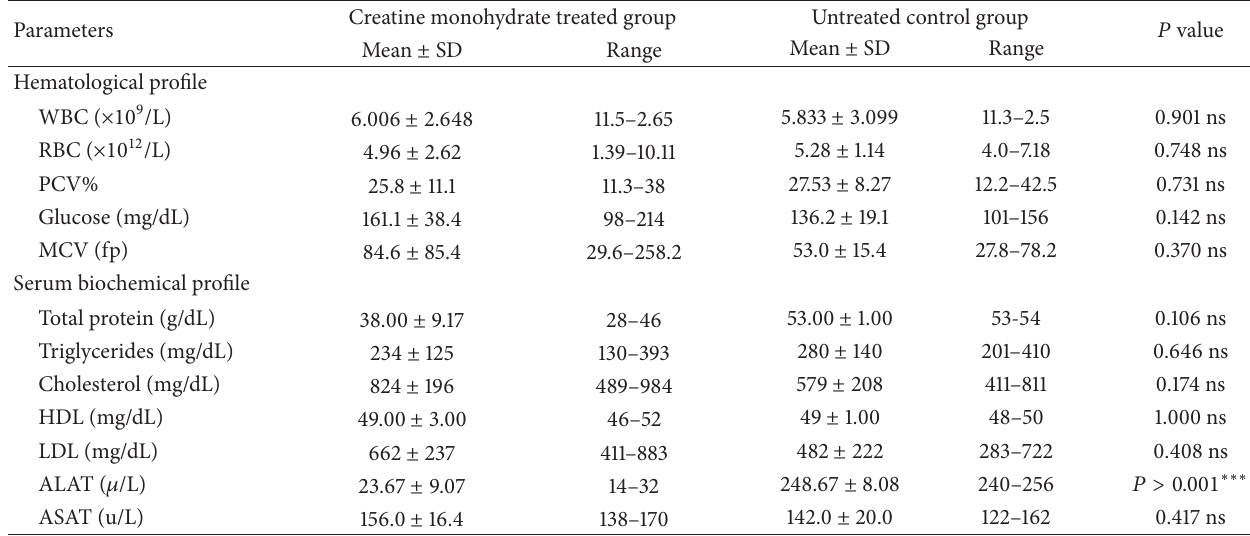
Table 1: Comparison of various hematological and serum biochemical parameters between 2% creatine monohydrate treated and untreated (control) male albino mice for 8 weeks following hypoxia and ischemia: data is expressed as mean ± standard deviation.